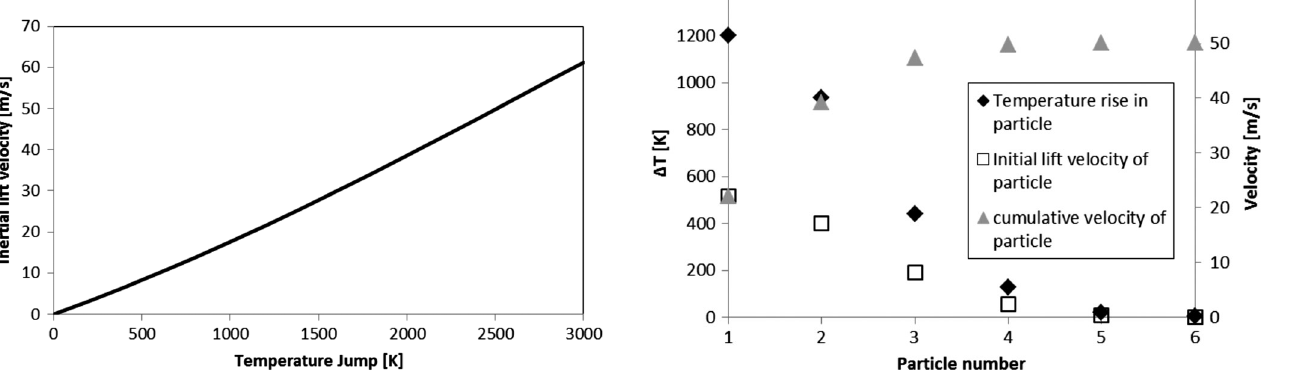
FIG. 7. Lift velocity as a function of instantaneous temperature jump.